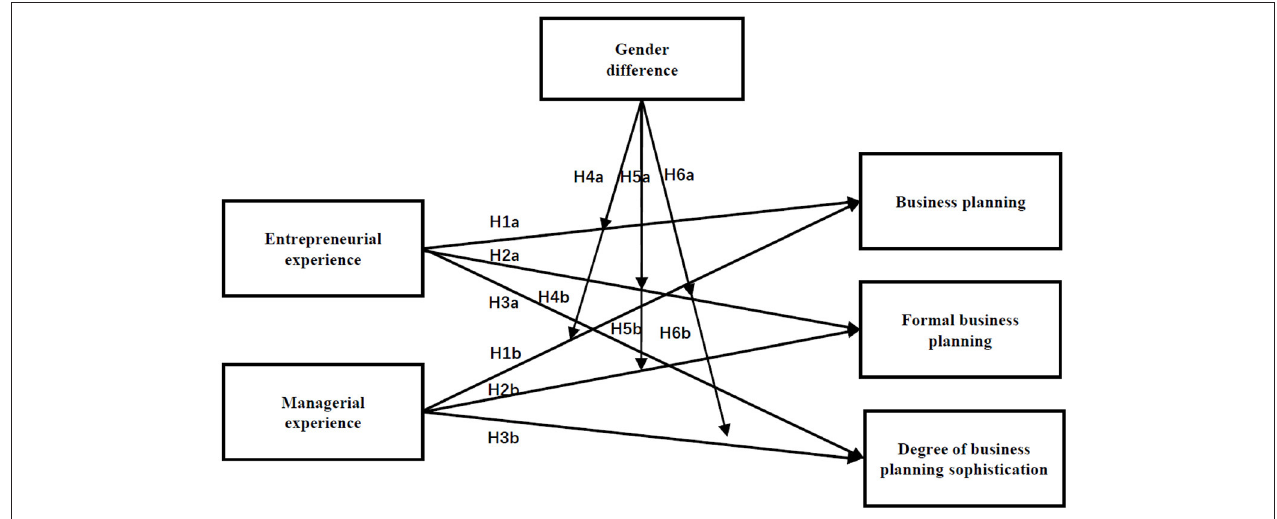
FIGURE 1 | Conceptual model of the